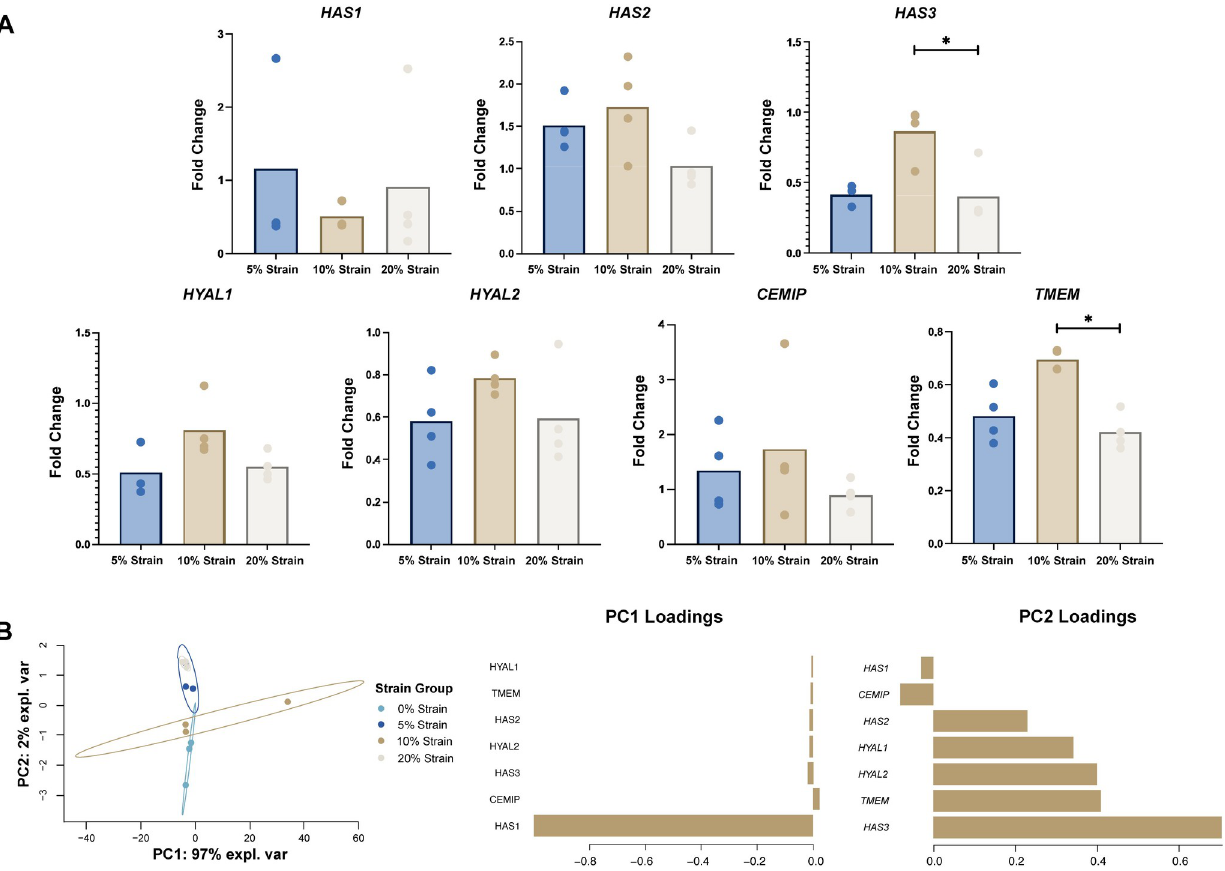
Fig 3. Changes in strain magnitude have limited effects on hyaluronan turnover genes compared to 0%-strain conditions. A) Mean fold difference in gene expression of loaded samples was calculated with respect to 0% strain group. Dots represent replicates and significant difference ( � , p < 0.05) between groups are shown with brackets. B) sparse PCA of gene expression clustered by strain group, with associated loadings plots. sPCA is shown as a scatter plot in the X-Y representative space of the gene expression data along PC1 and PC2, which explain over 99% of the variation in the